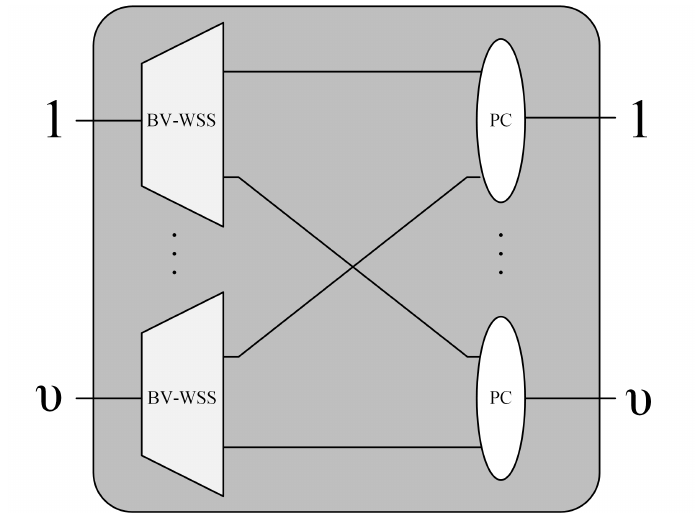
Figure 4. A second stage switch. BV-WSS—bandwidth variable wavelength selective switch; PC— passive